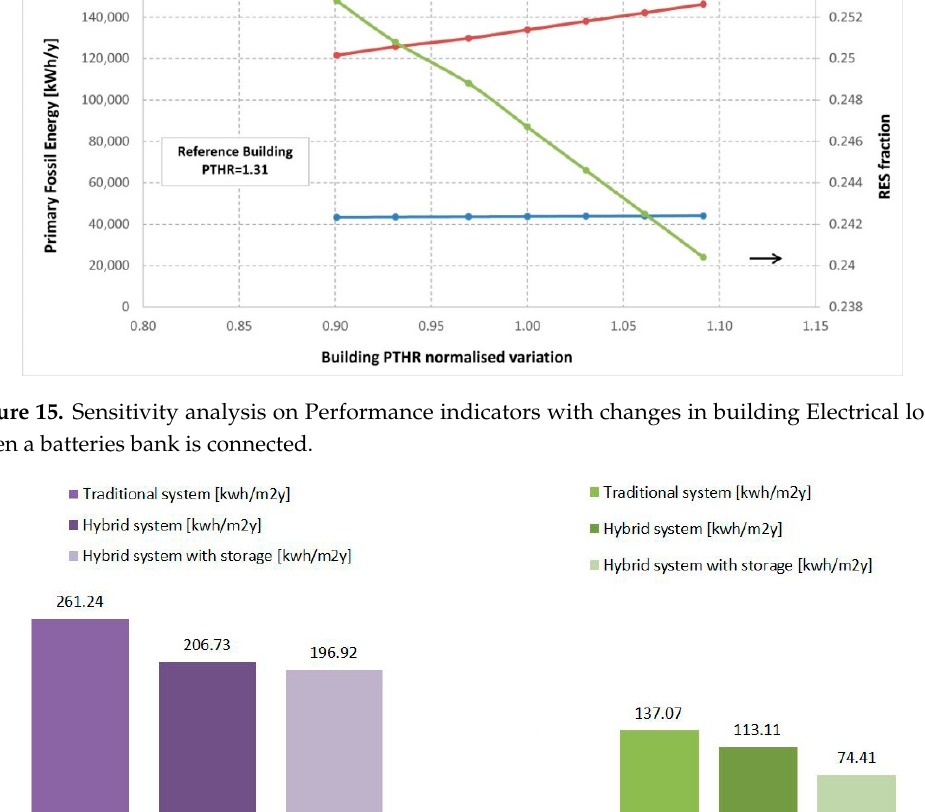
Figure 16. Normalized building primary fossil energy need over one year ( a ), normalized building primary fossil energy need over one year neglecting the electricity contribution ( b ).